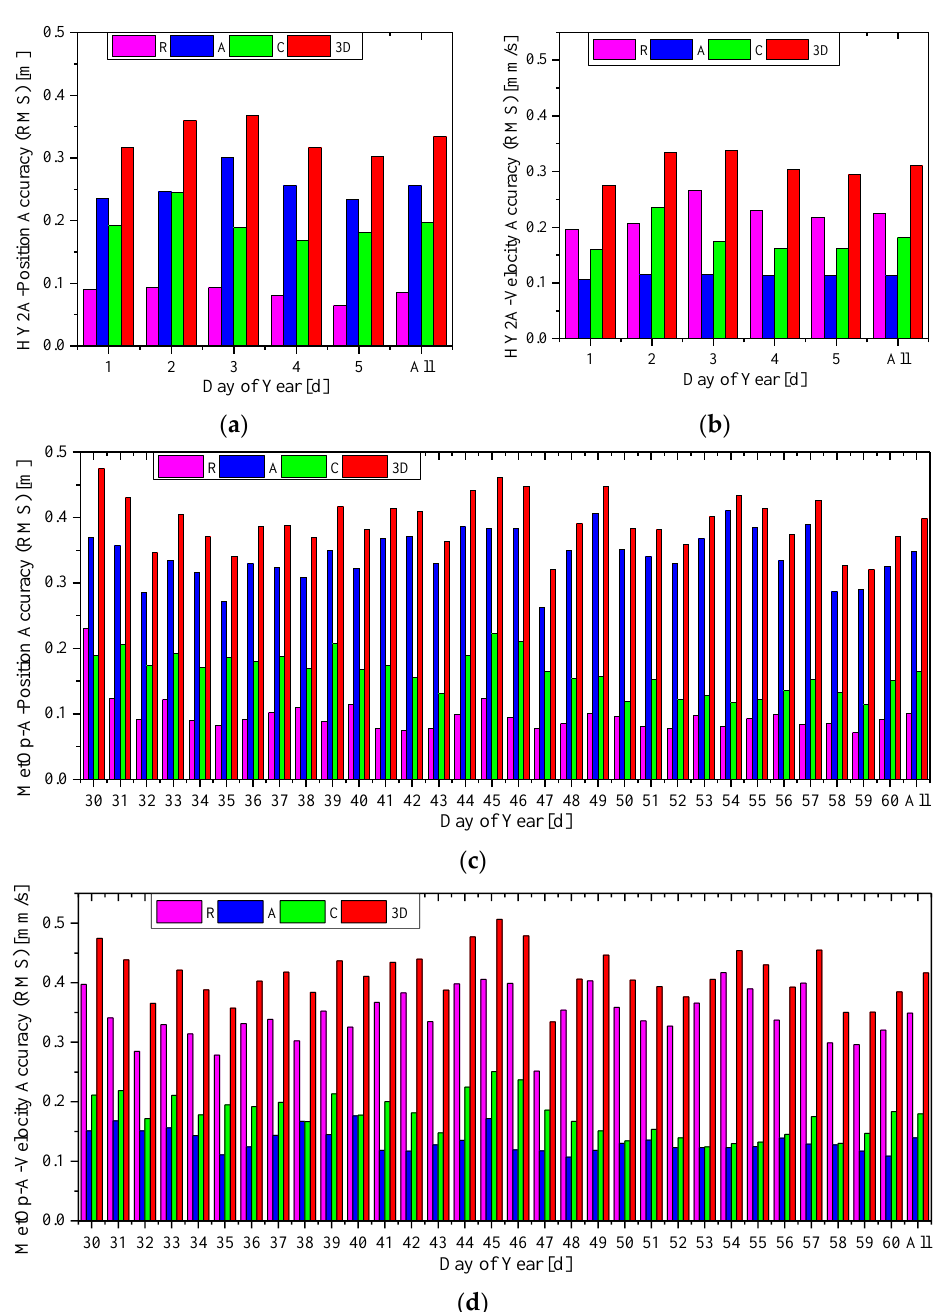
Figure 8. Orbit accuracy of the carrier-phase based solutions for HY2A and MetOp-A. ( a ) Position accuracy of HY2A; ( b ) velocity accuracy of HY2A; ( c ) position accuracy of MetOp-A; and ( d ) velocity accuracy of MetOp-A.